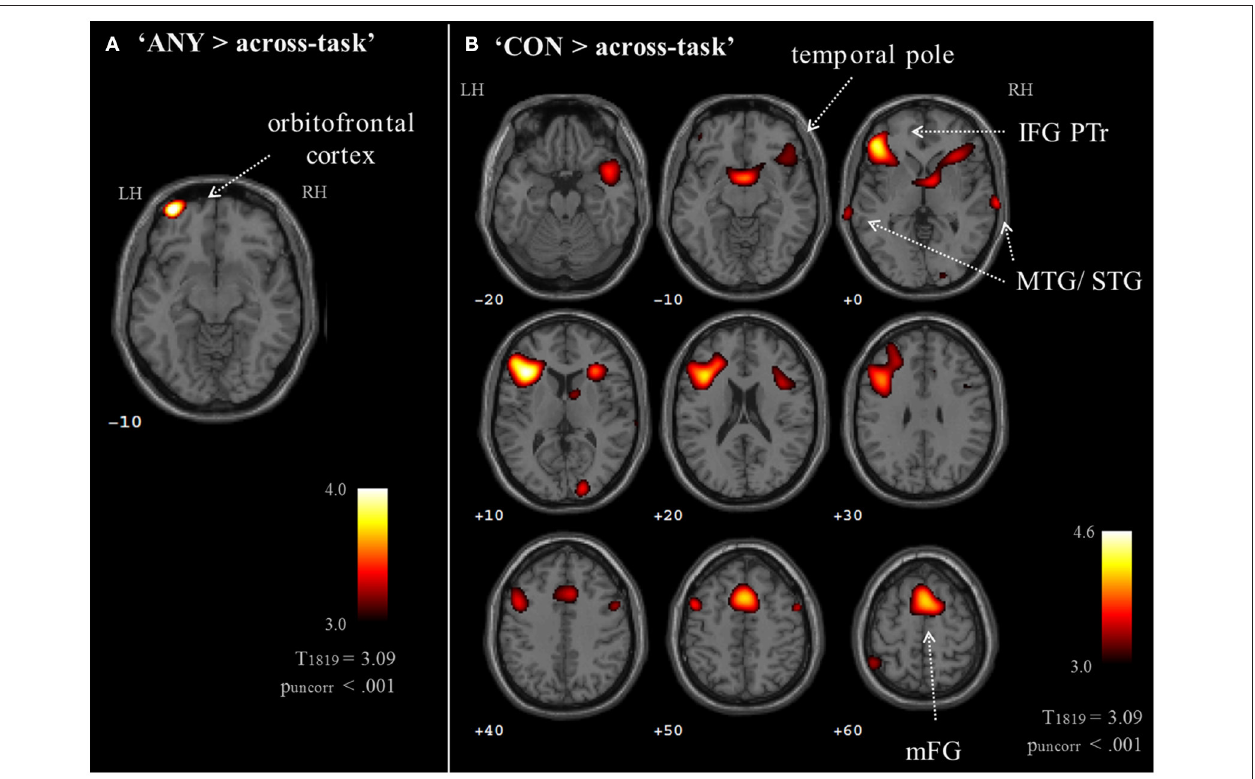
FIGURE 5 | Exploratory whole brain maps for task effects. Exploratory t-maps (p uncorr < 0.001; cluster threshold: 10 voxels) compared each task map to the across-task condition. (A) The contrast “ANY > across-task” revealed increased ISC at the left orbitofrontal cortex. (B) The contrast “CON > across-task” confirmed the left IFG response and further revealed contributions of the medial frontal gyrus, bilateral temporal cortices, right IFG, precentral gyrus, and cuneus. The contrast “REL > across-task” did not yield results on a whole-brain map. MTG, middle temporal gyrus; STG, superior temporal gyrus; IFG PTr, inferior frontal gyrus, pars